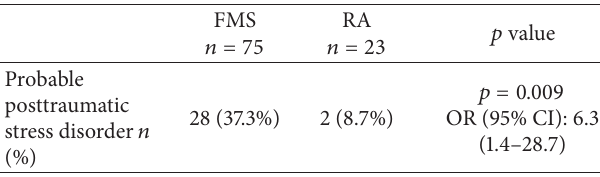
Table 5: Comparison of probable posttraumatic stress disorder basedonretrospectivereportsonlifetimetraumaticevents(assessed by the trauma list of the PDS: frequency ≥ 10 in at least one group and DSM-IV diagnosis criteria for